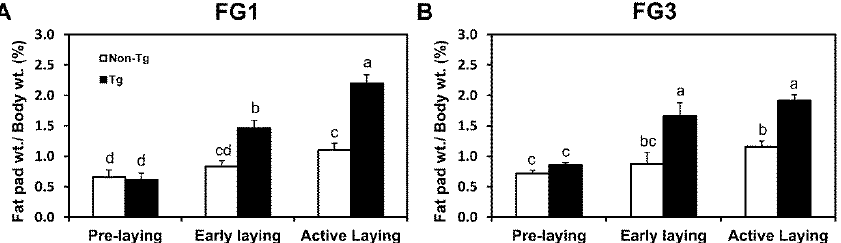
Figure 1. G0S2 overexpression prevents loss of adipose mass during egg laying. ( A ) Line FG1 and ( B ) line FG3 interclavicular fat pad weights as a percentage of body weights in non-transgenic and transgenic quail at pre-laying, early laying, and active laying ( n = 5 per group per time point). Bars represent mean ˘ SEM. Bars that share the same superscript letter are not significantly different from each other ( p < 0.05).